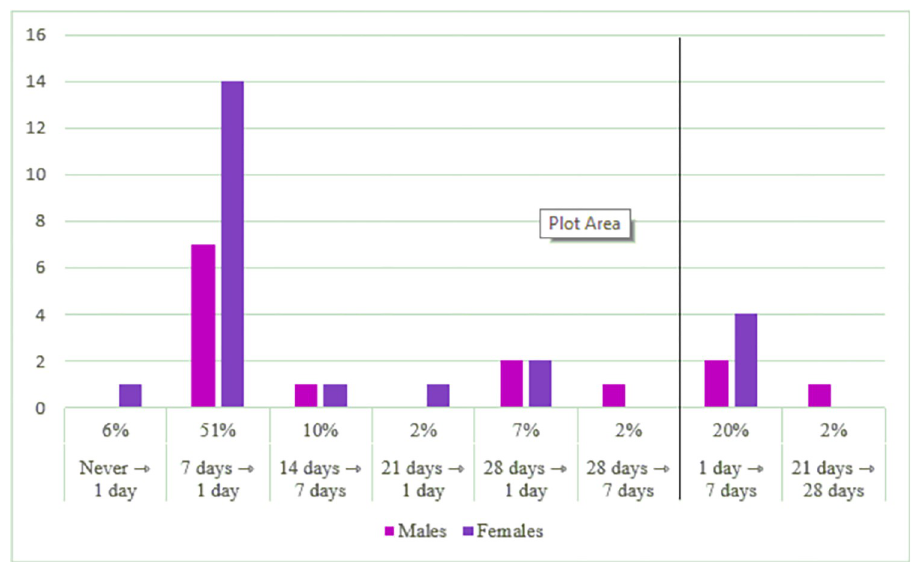
Fig 1. Preference changes for laboratory test results.